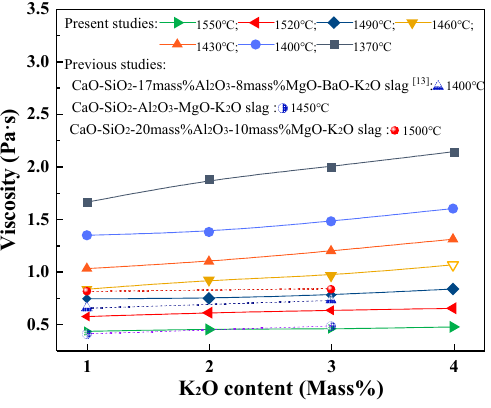
Figure 4. K 2 O content dependence on the viscosity of the slags at the temperature between 1370 °C and 1550 °C.